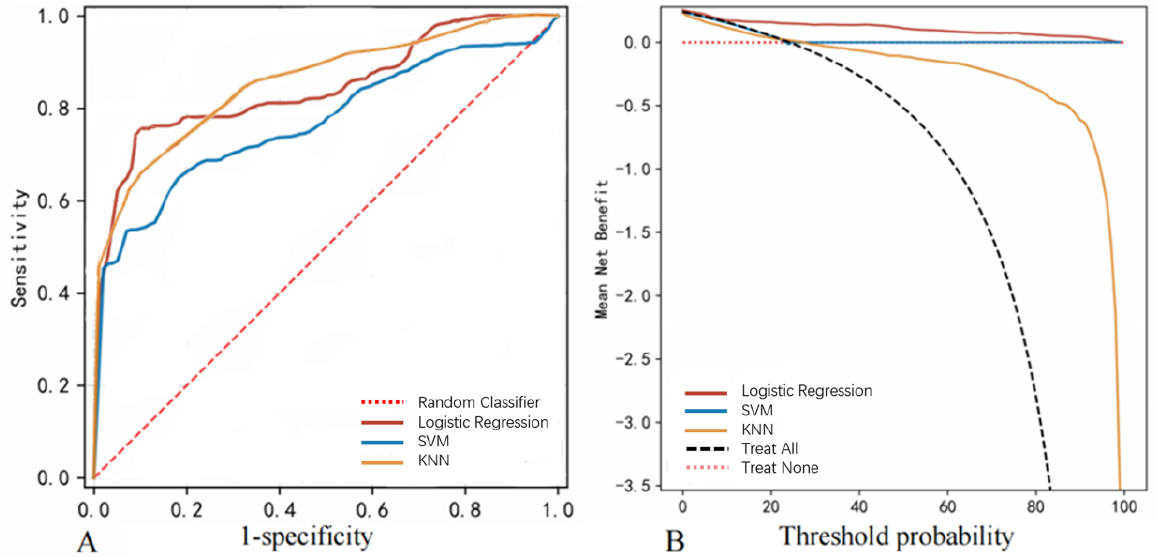
Figure 3. Model performance using the training dataset. ( A ) The ROC curve of the logistic regression, SVM, and KNN models. ( B ) The DCA of the logistic regression, SVM, and KNN models. The thick solid line signifies the assumption that no intracranial infection occurred in any patient on the y -axis.